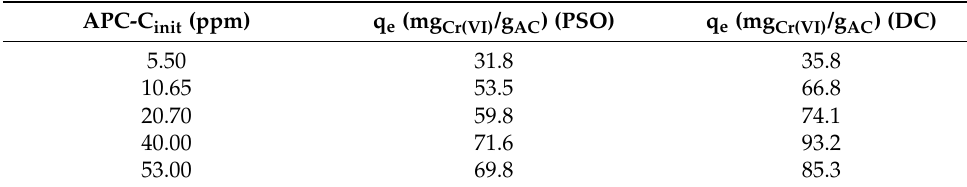
Table 4. Predicted Cr(VI) APC adsorption capacity for Cr(VI) at the equilibrium stage for pH = 3 and T = 23 ◦ C. APC-C init